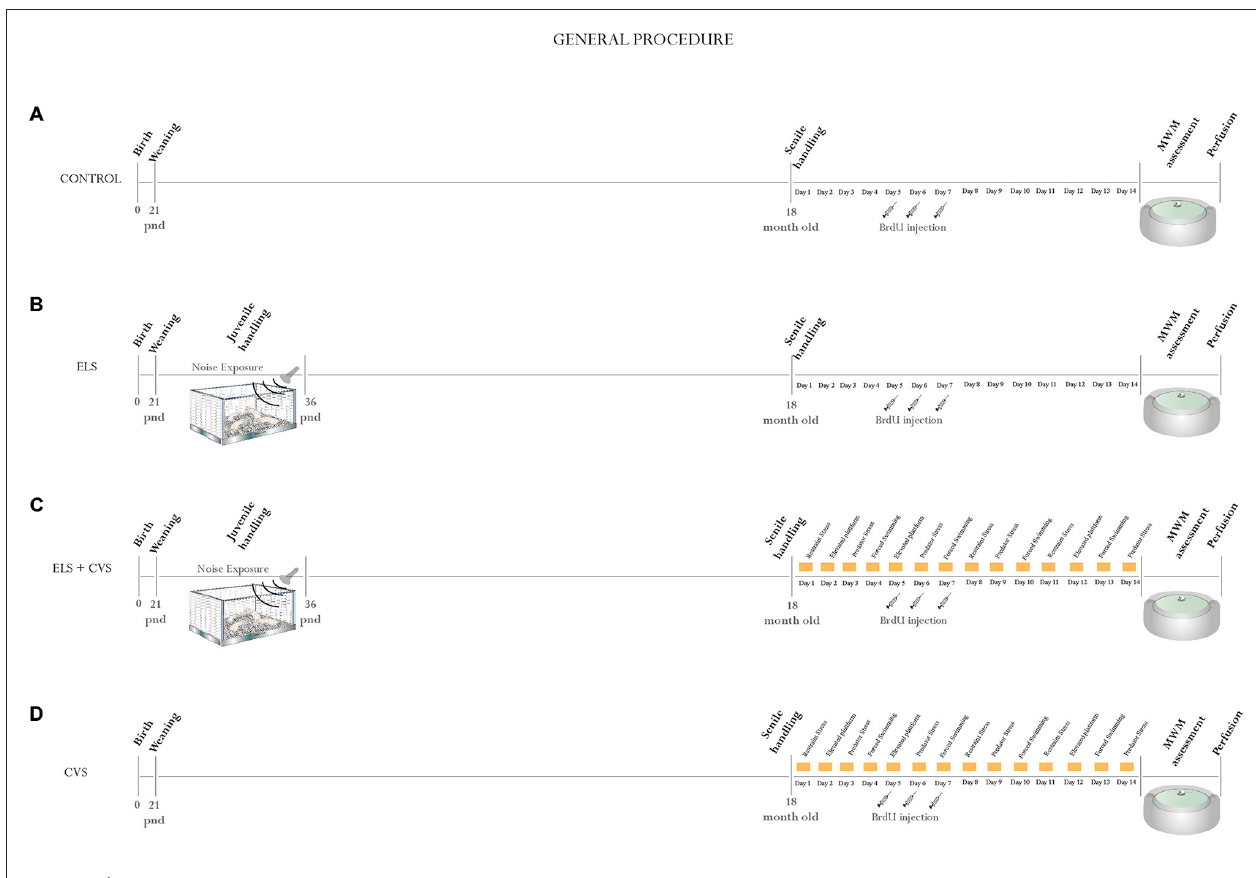
FIGURE 1 | General procedure: Illustrates the general procedure followed in our experiment for the (A) Control group, (B) Early-life stress (ELS) group, (C) Early-life stress + Chronic variable stress